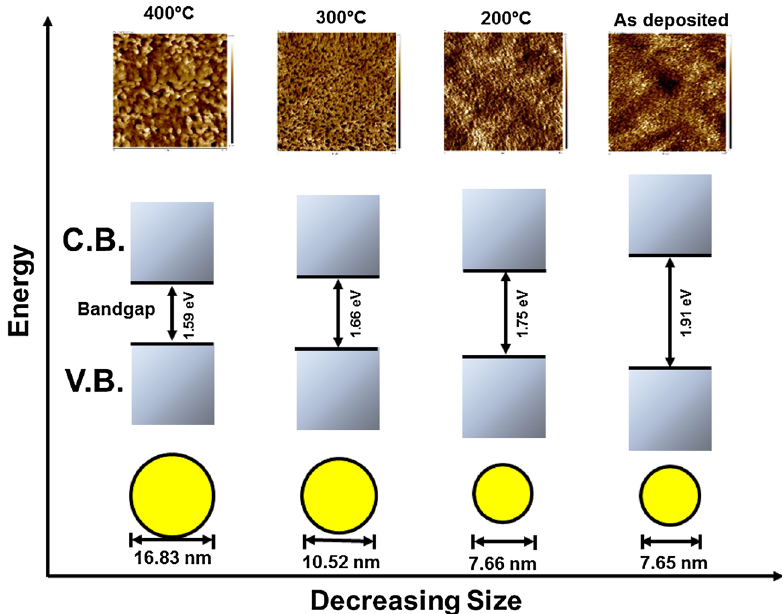
Fig. 7 Graphical presentation of dependence bandgap on average grain size of as-